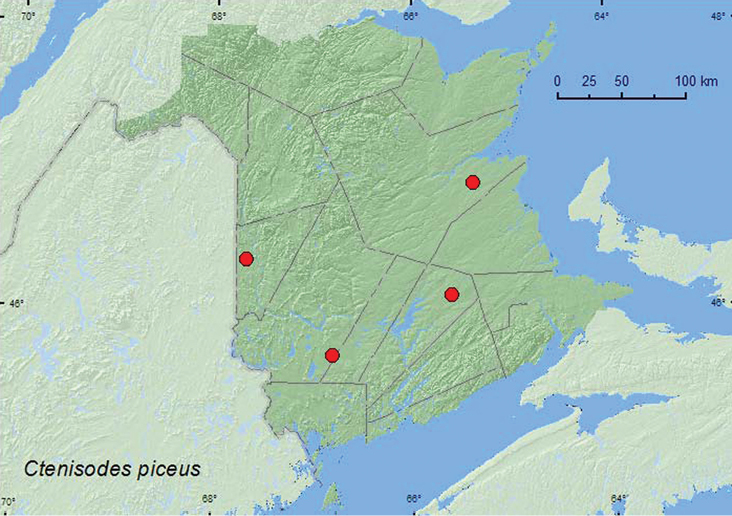
Collection localities in New Brunswick, Canada of Ctenisodes piceus.